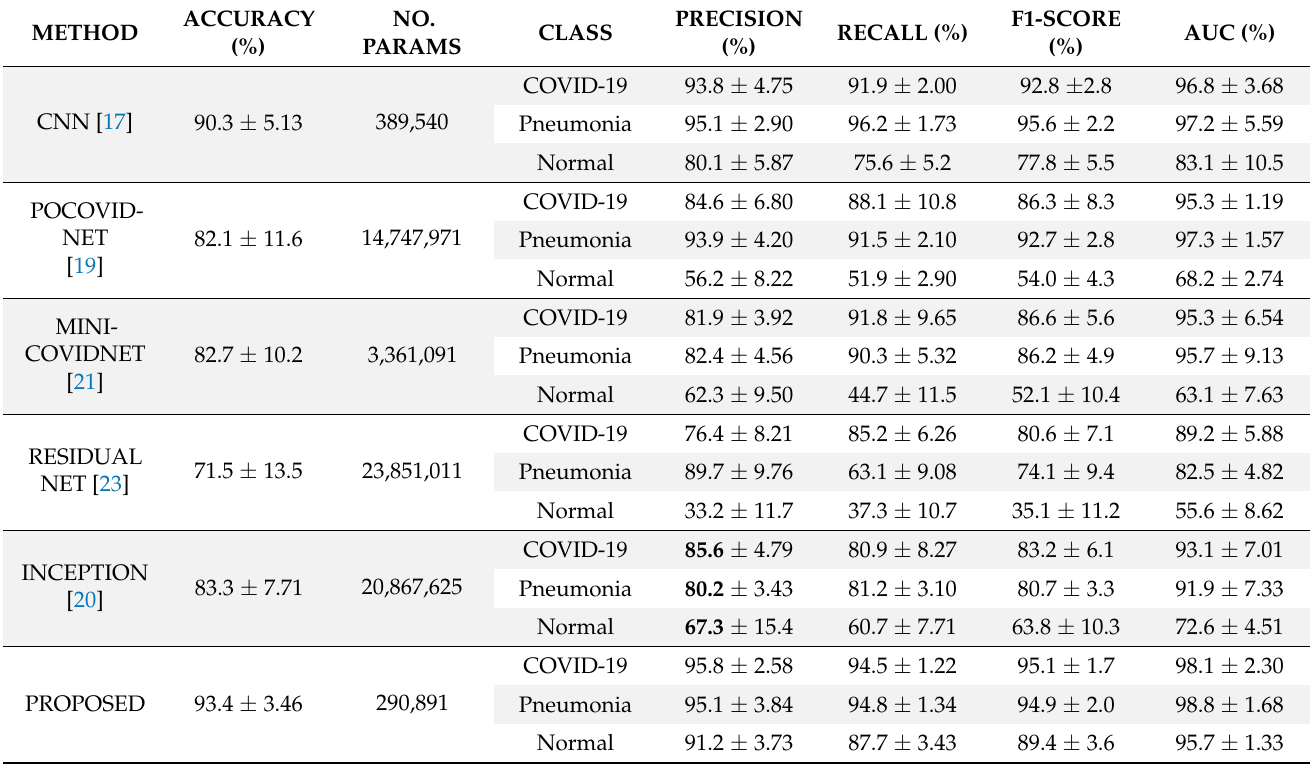
Table 2. Comparison of the 5-Fold cross-validation performance (mean ± std) of the proposed methods and competing models for COVID-19 screening from a frame-based lung ultrasound dataset. The Precision, Recall, F1-score, and AUC metrics are reported for each class.